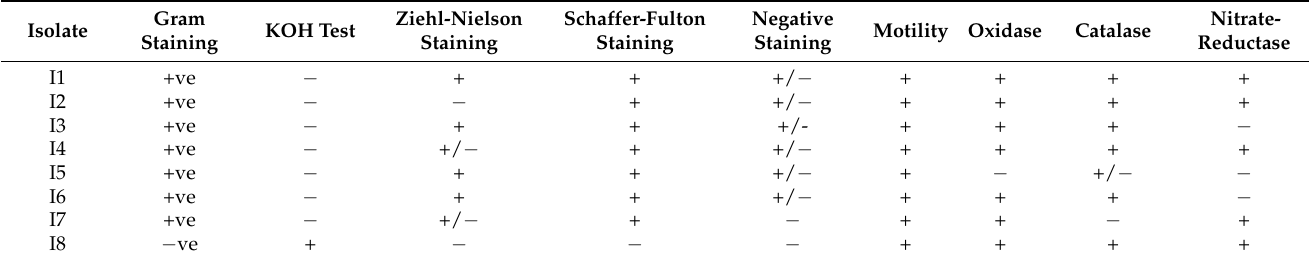
Table 4. Results of staining, KOH test and biochemical tests for each isolate of